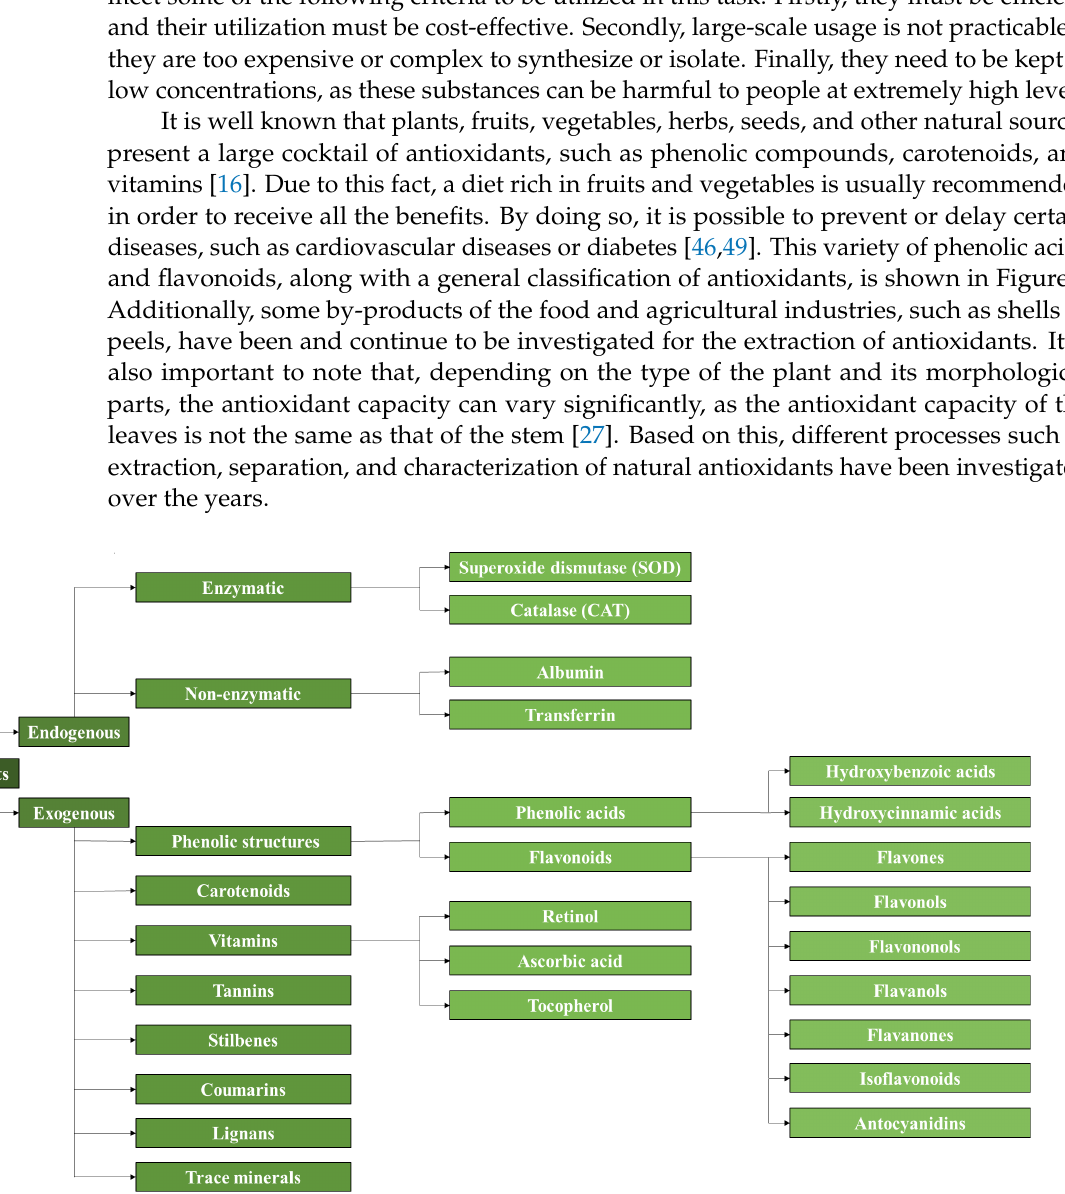
Figure 1. Classification of natural antioxidants [46].